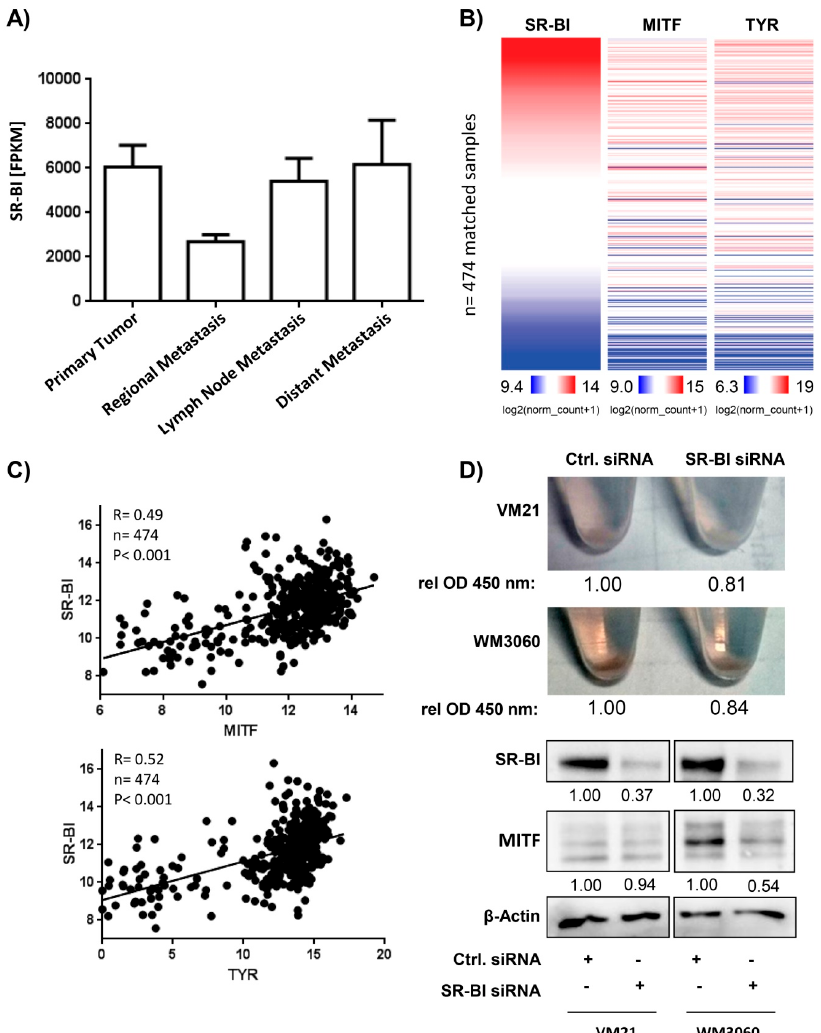
Figure 1. Scavenger receptor class B type 1 (SR-BI) is involved in the melanoma pigmentation pathway. ( A ) Expression levels of SR-BI in different tumor samples from melanoma patients. Mean with 95% confidence intervals is shown. FPKM = fragments per kilobase million. ( B ) Co-expression pattern of SR-BI with MITF and tyrosinase ( TYR ) from 474 matched melanoma samples. ( C ) Correlation of SR-BI with MITF (upper graph) and TYR (lower graph) expression in patient samples derived from metastatic lesions by the TCGA consortium . ( D ) Representative images of pelleted cells treated either with control siRNA or SR-BI siRNA. Immunoblotting of pigmented human melanoma cell lines VM21 and WM3060 after SR-BI knockdown showing SR-BI and MITF. β -ACTIN was used as loading control. rel OD = relative optical density.